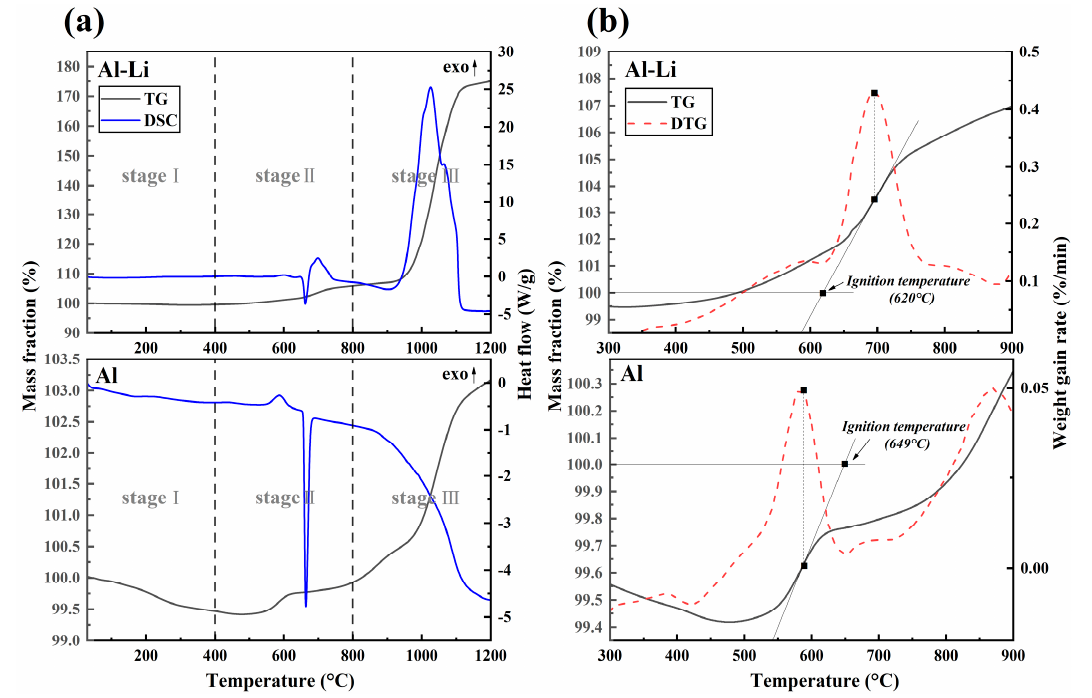
Figure 6. Thermal analysis curves of Al-Li alloy and Al powder in air: ( a ) TG-DSC; ( b ) TG-DTG.